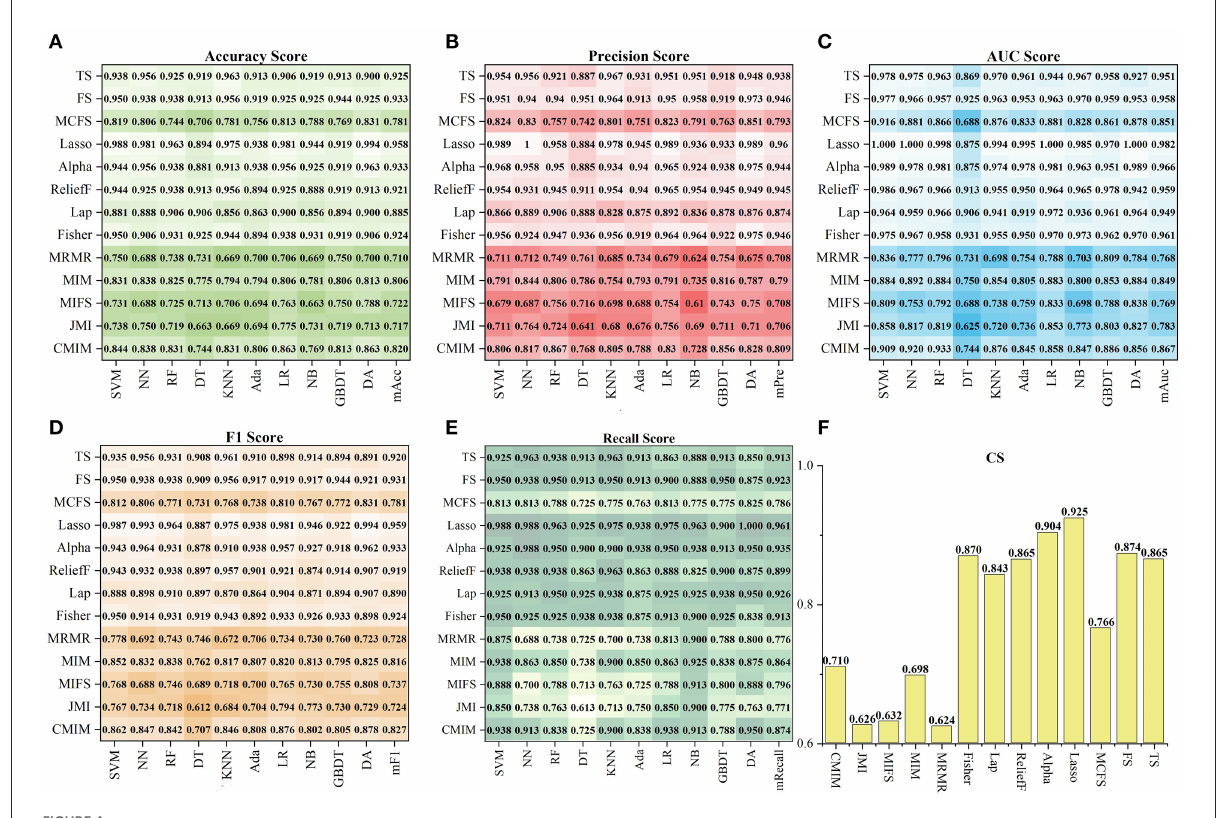
FIGURE4 The performance of 13 feature sets on the ten models. (A–E) Show the five index (Acc, Pre, Auc, F1, Recall) results, and (F) shows the corresponding